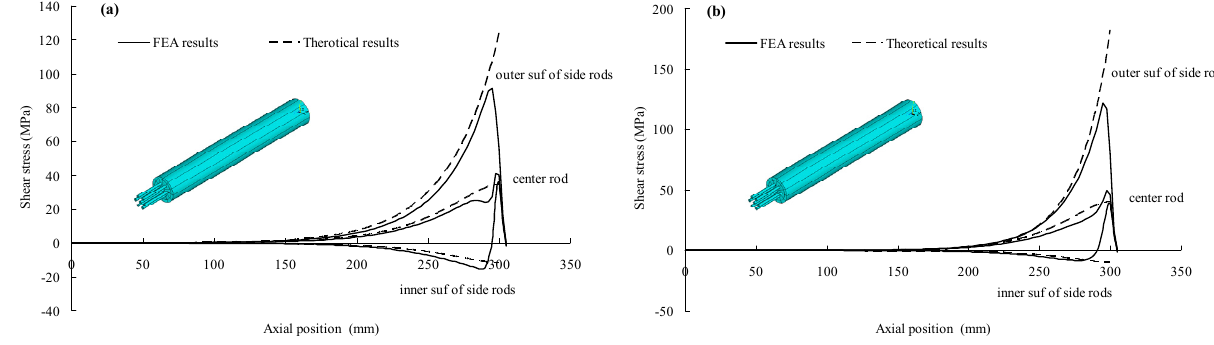
Figure 8. ( a ) Shear stress distribution of Case 1; ( b ) shear stress distribution of Case